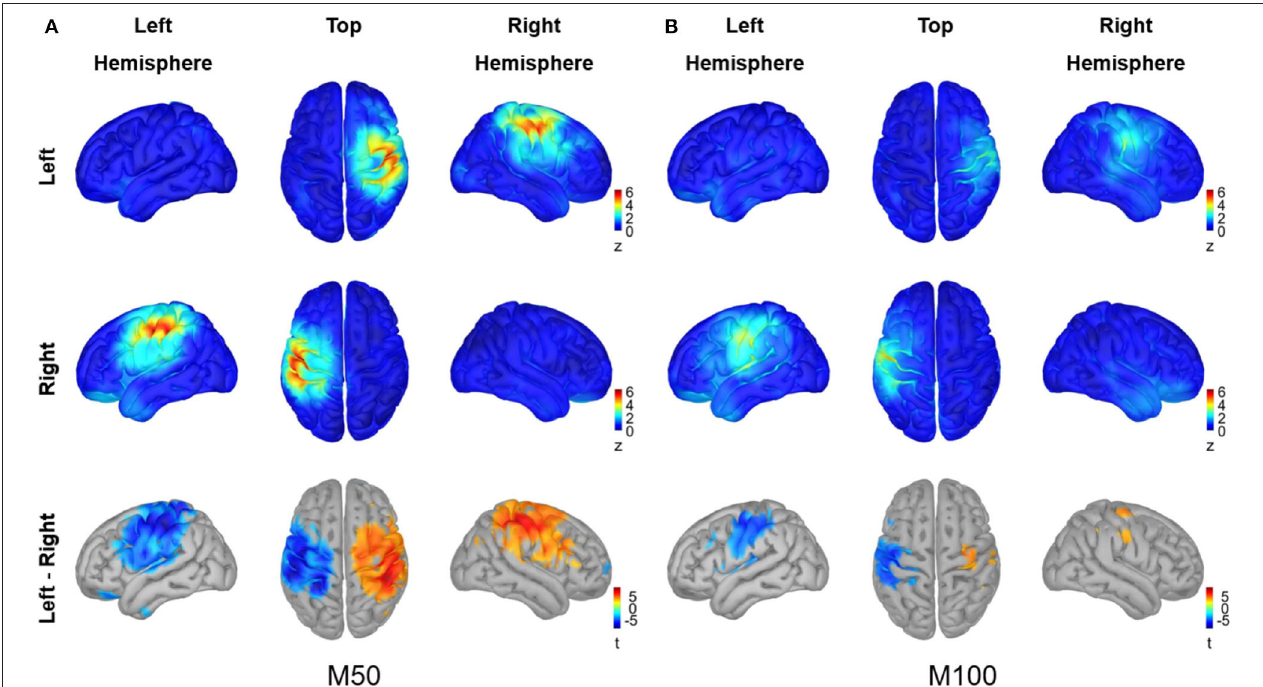
FIGURE 4 | Source analysis of peak MEG responses to vibrotactile stimulation. The grand averaged source activity (A) for M50 responses and (B) for M100 responses are illustrated. The average z-scores with a 10 ms interval around each peak, i.e., 46–66 ms for M50 and 90–110 ms for M100, are plotted for the left index finger stimulation condition (top panel) and for the right index finger stimulation condition (middle panel), respectively. In the lower panel, the statistical t-maps of areas showing a significant difference between left and right stimulation conditions are plotted, with the red color indicating greater activity for the left index finger stimulation compared with the left index finger stimulation (permutation paired t -test, 10,000 randomizations, α = 0.01, FDR corrected). For each panel, views from the left hemisphere, top, and the right hemisphere are presented